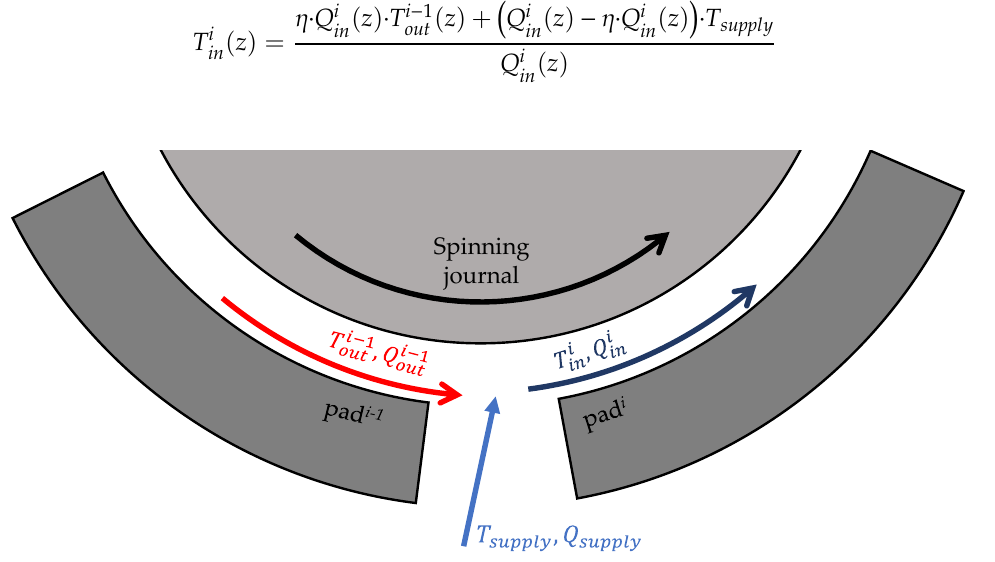
Figure 2. Schematic diagram of oil inlet groove and boundary conditions at pad edges.